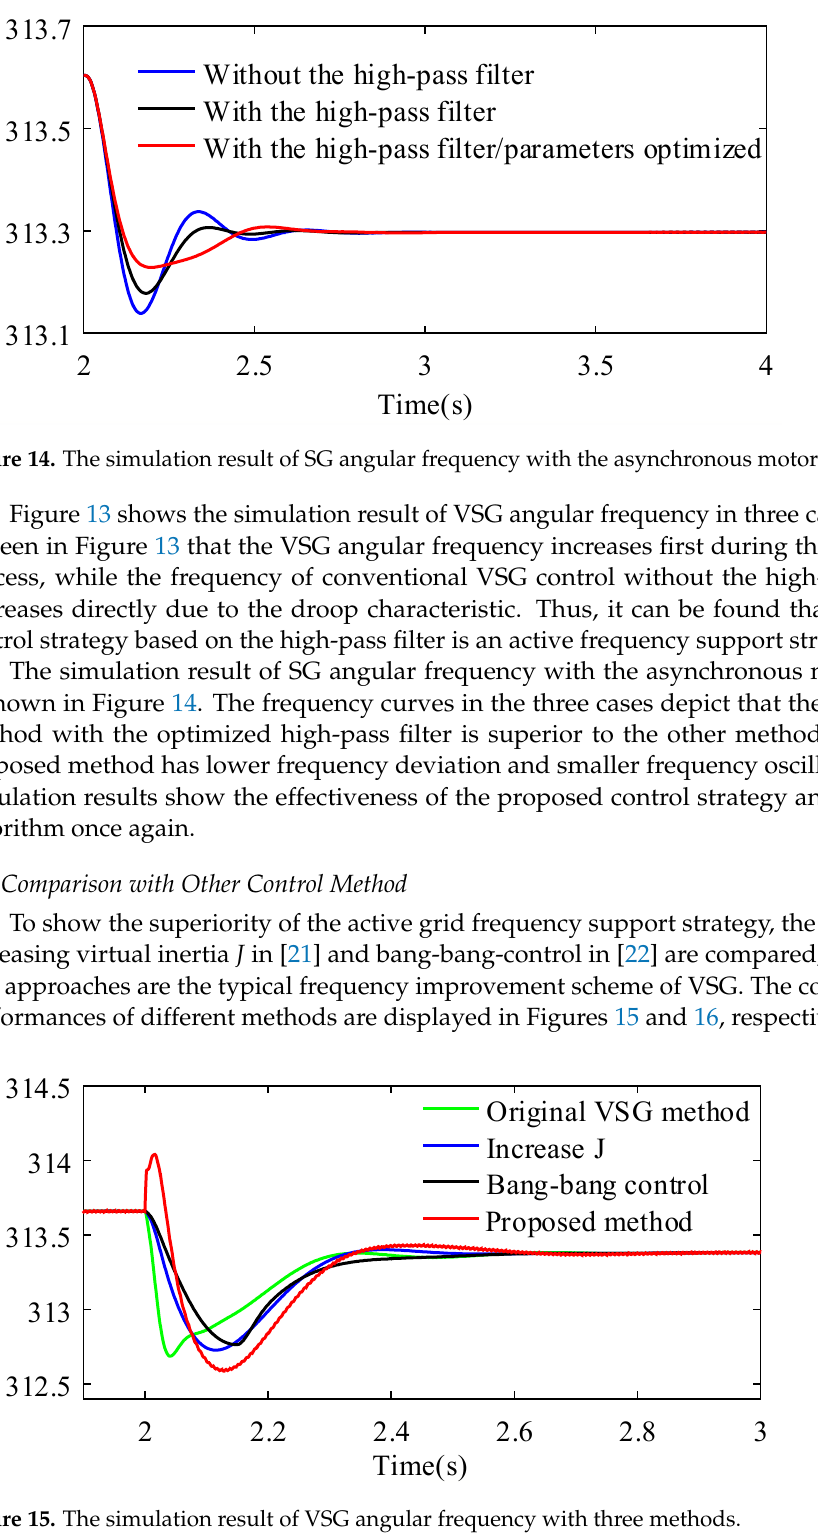
Figure 15. The simulation result of VSG angular frequency with three methods.